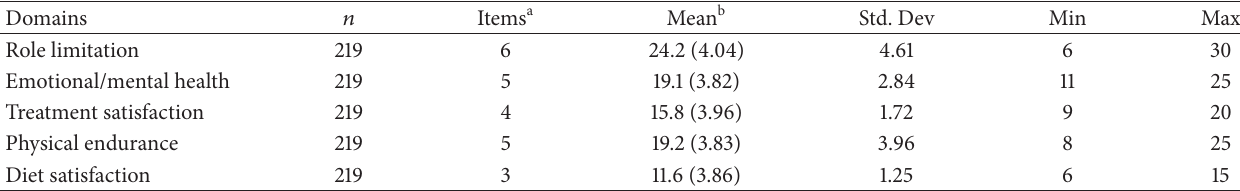
Table 4: Summary statistics on quality of